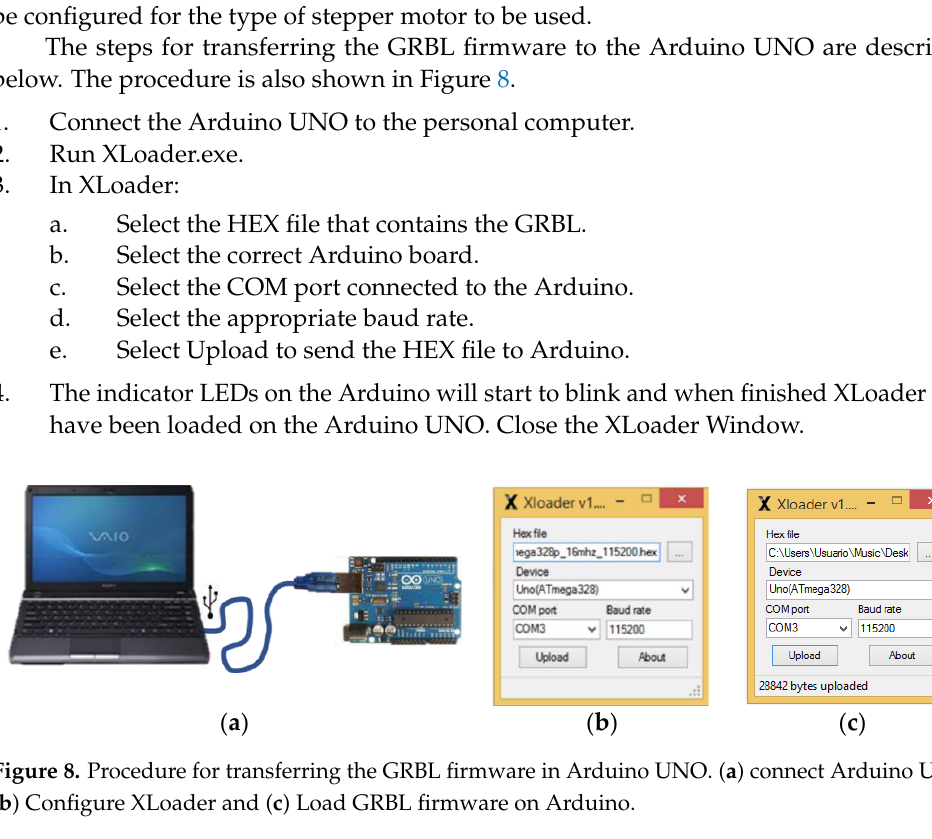
Figure 9. Universal Gcode Sender. The Universal Gcode Sender is used to configure the GRBL (it must be connected to the Arduino UNO), in the command window enter $$. The parameters to configure will be displayed; to modify any, write $x = value. In this part, the motors and the linear dis- placement system (screw) are configured. 2.4. Hardware Configuration Figure 10 shows the current and reference voltage relationship of the Nema 17 motor, and as suggested by the controller ’ s technical data sheets, it is suggested to adjust to 70% of the nominal motor current to calculate the V ref . For the stepping motors used, the Driv- ers were configured as shown in Table 5. Figure 11 shows how to adjust the V ref in the A4988 driver.